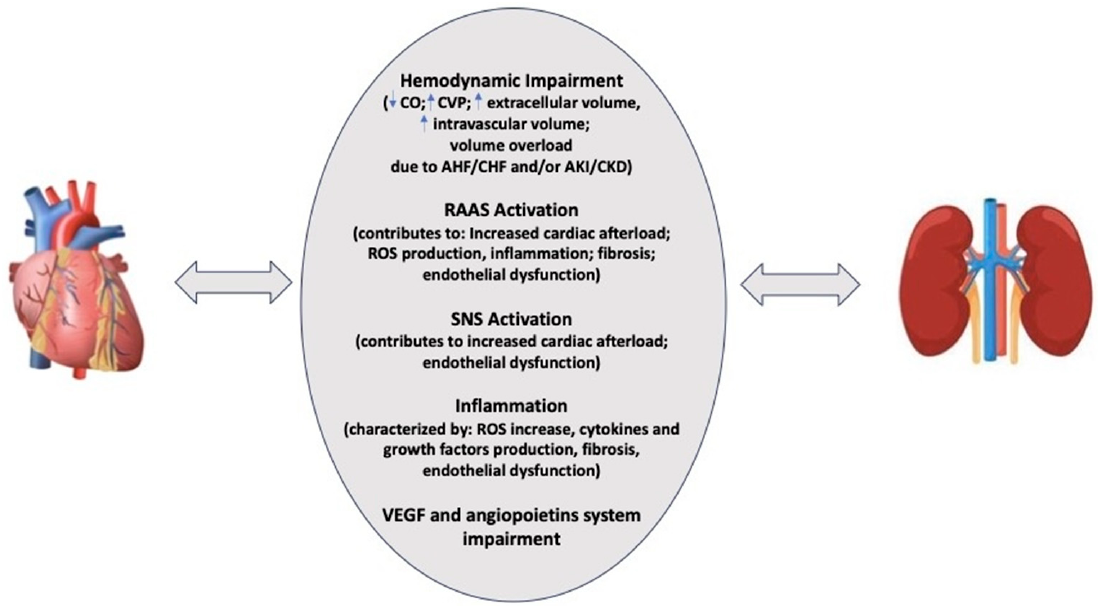
Figure 1. Main pathophysiological mechanisms of heart and kidney damage in cardiorenal syndrome. ↓ reduced; ↑ increased; AHF, Acute Heart Failure; AKI, Acute Kidney Injury; CHF, chronic heart failure; CKD, Chronic Kidney Disease; CO, Cardiac Output; CVP, Central Venous Pressure; RAAS, Renin Angiotensin Aldosterone System; ROS, Reactive Oxygen Species; SNS, Sympathetic Nervous System; VEGF, Vascular Endothelial Growth Factor.